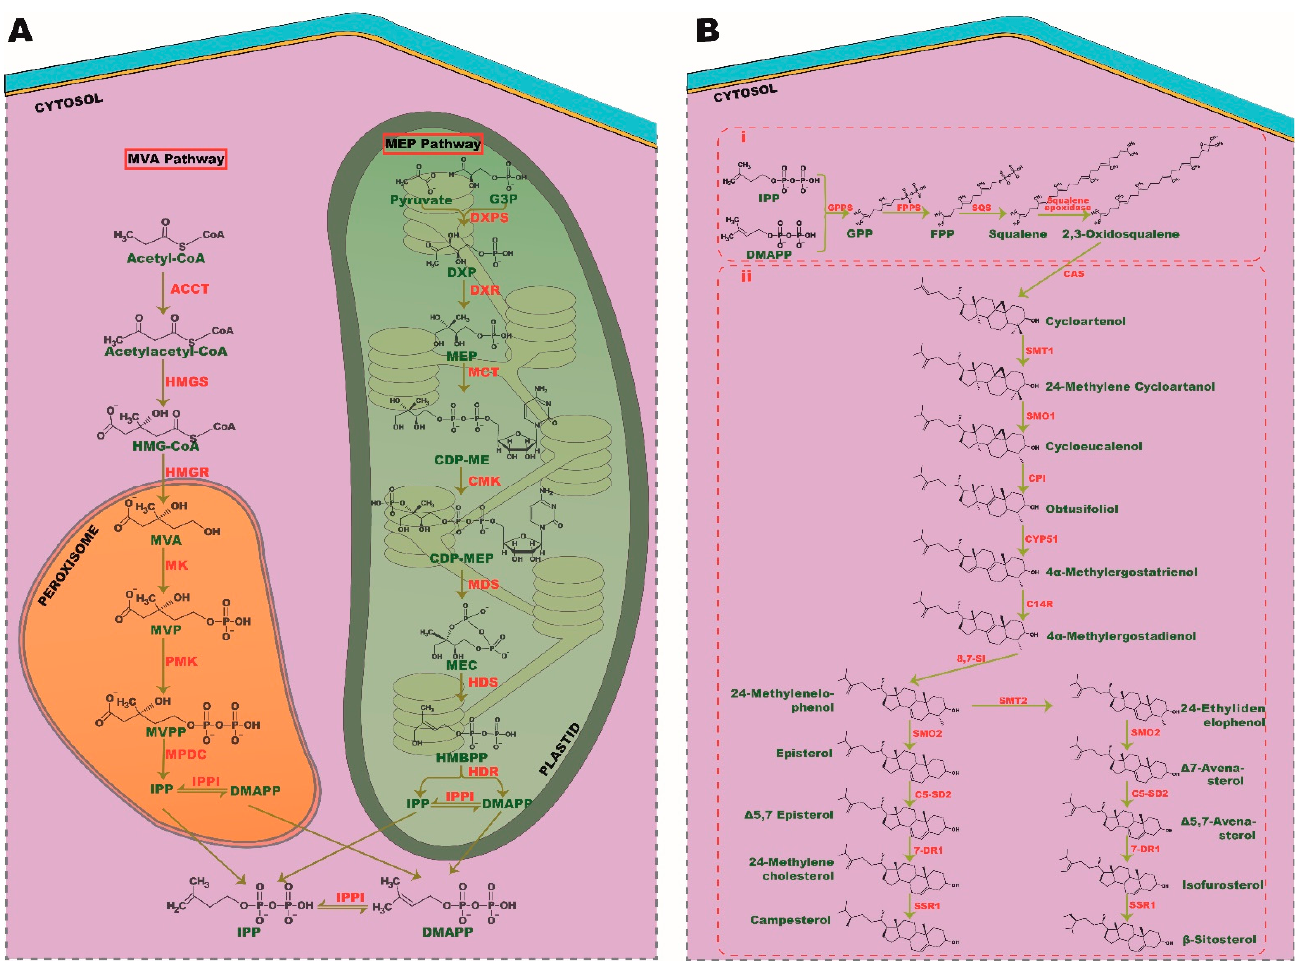
Figure 1. Biosynthesis pathways of phytosterols. ( A ) Isoprene unit, IPP, and DMAPP synthesis. A product of glucose metabolism, acetyl-coA and pyruvate is converted into isoprene units through MVA and MEP pathway, respectively. ( B ) (i) Condensation of isoprene into triterpenoids and (ii) phytosterol synthesis. SMT, sterol C-24 methyl transferase; SMO, sterol C-4 methyl oxidase; CPI, cyclopropyl sterol isomerase; CYP51, sterol C-14 demethylase; C-14R, sterol C-14 reductase; 8, 7-SI, sterol 8, 7 isomerase; C5-SD2, sterol C5(6) desaturase; 7DR1, 7-dehydrocholesterol, SSR1, sterol side-chain reductase 1.